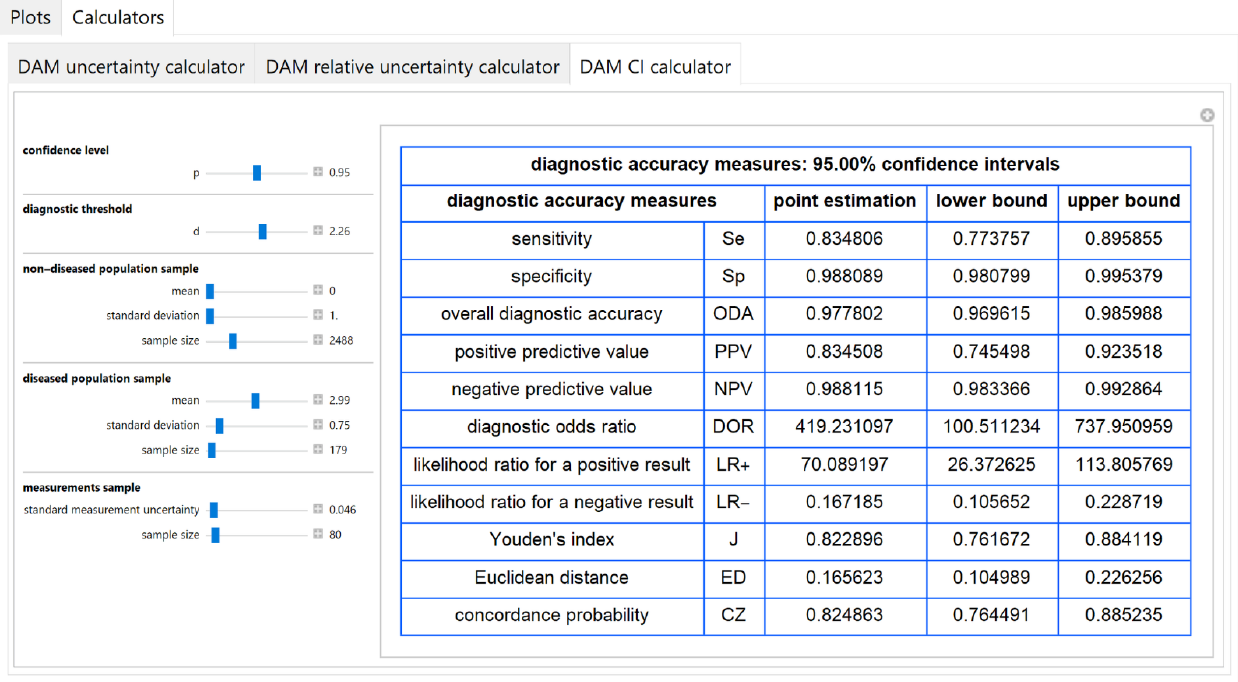
Figure 14. Calculators module, DAM CI calculator module screenshot. Calculated point estimations and confidence intervals of diagnostic accuracy measures, with the settings shown on the left. The respective parameter settings are also shown in Table 3.